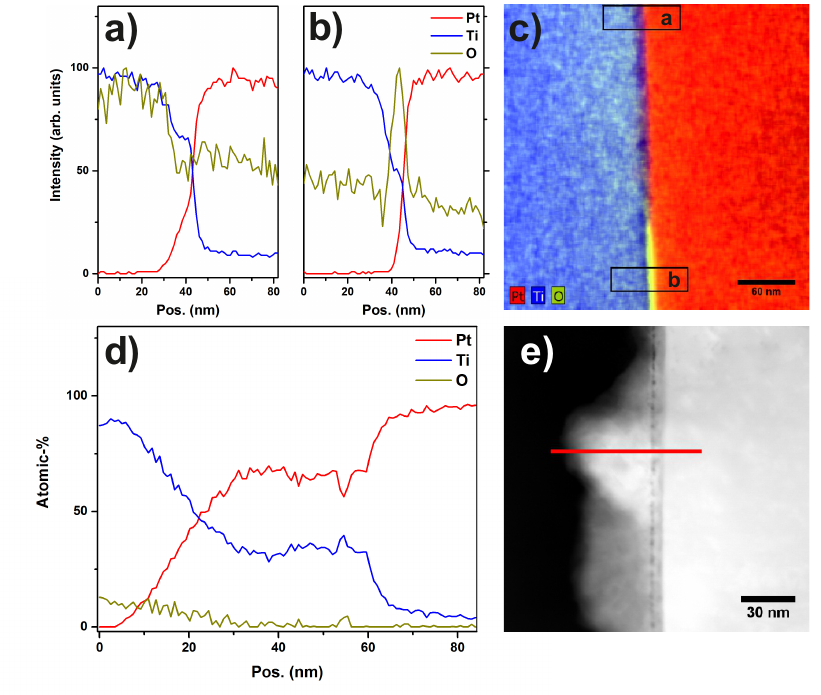
Figure 13. ( a , b ) EDX linescans across the interface between Pt catalyst particle and Ti substrate; ( c ) EDX map of the interface region with markers indicating the position of the extracted linescans; ( d ) EDX linescan of the diffusion zone at the interface between support and Pt catalyst particle. The atomic concentrations of Pt, Ti and O are shown; ( e ) STEM HAADF image indicating the region in which the linescan was